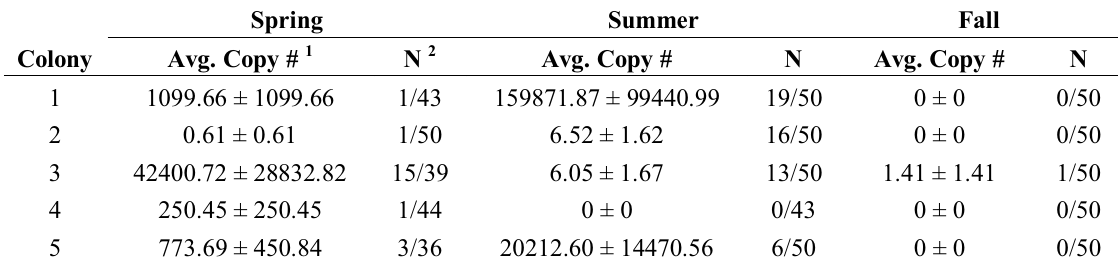
Table 1. Real-time PCR data for colonies over three seasons in 2010. Copy numbers reflect mean N . ceranae DNA copies in a standardized 50 ng DNA extract from individual worker bees.